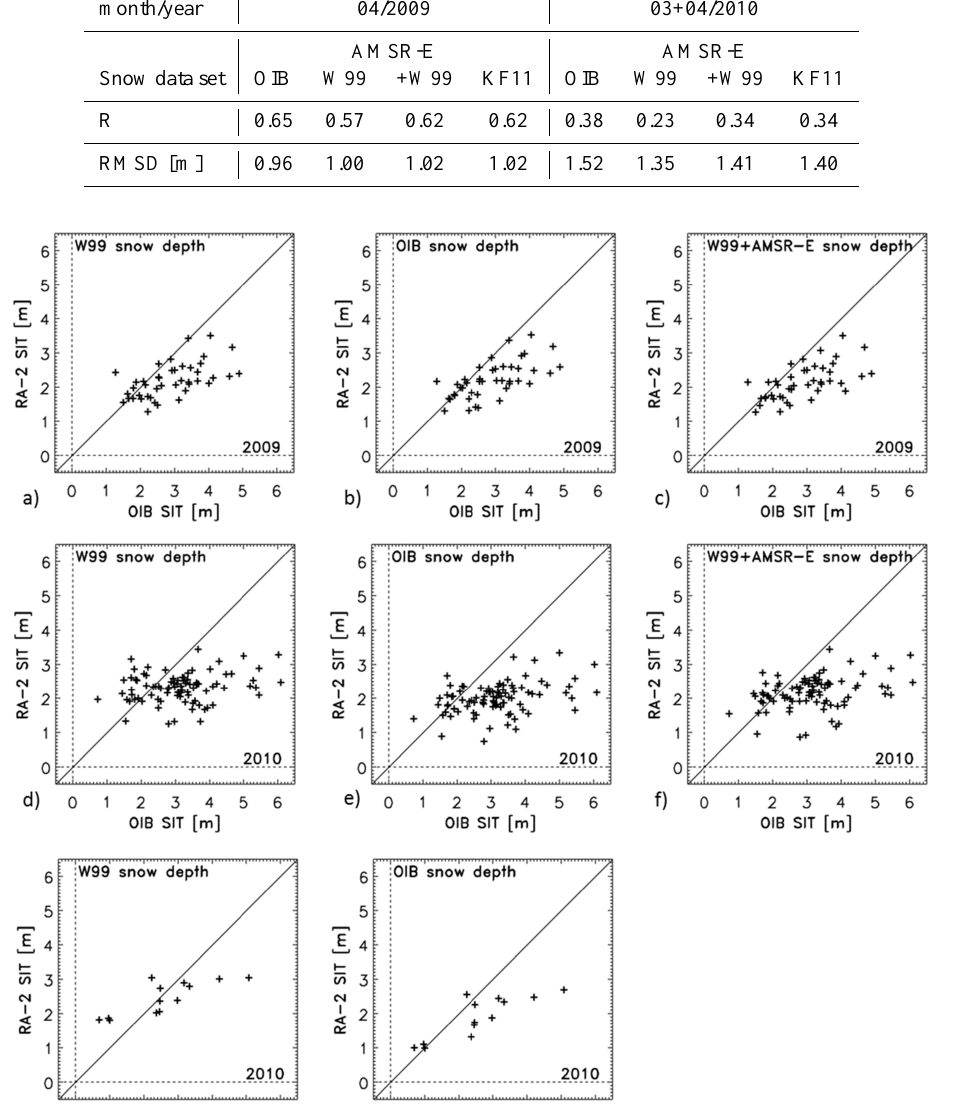
Table 6. Summary of comparison between RA-2 sea ice thickness computed using different snow depth data sets and OIB sea ice thickness for the Arctic Ocean. Total number of data pairs is N = 43 for 2009 and N = 90 for 2010.